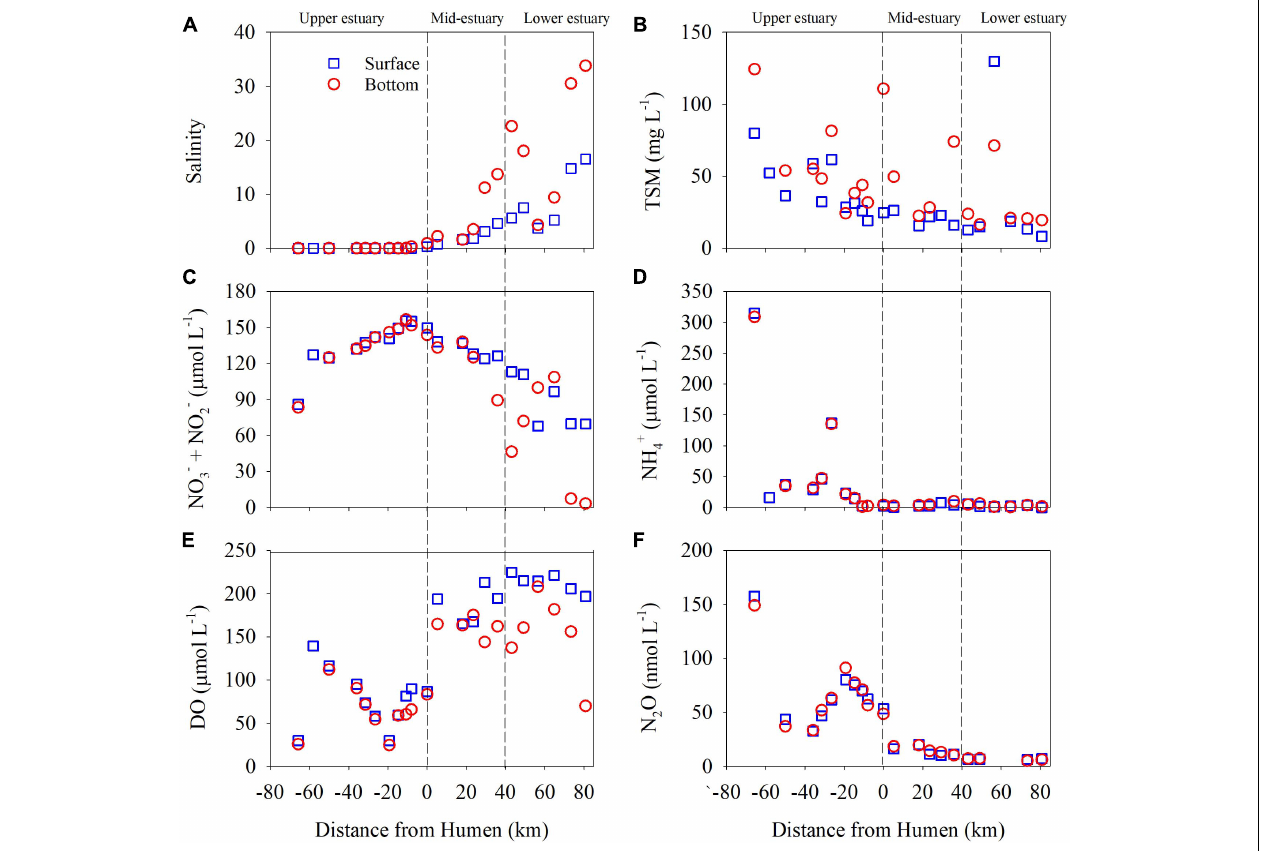
FIGURE 2 | The distributions of salinity (A) , total suspended matter (TSM) (B) , nitrate (NO 3 − ) + nitrite (NO 2 − ) (C) , ammonium (NH 4 + ) (D) , dissolved oxygen (DO) (E) , and nitrous oxide (N 2 O) (F) in the Pearl River estuary in July 2014. The dotted vertical lines separate the study sites into the upper, mid, and lower estuarine regions. The salinity and DO datasets in the mid and lower regions (Lingdingyang) were reported previously by Su et al. (2017). The blue open squares and red open dots represent samples collected in the surface and bottom waters, respectively. Humen Outlet is represented here at 0 km. Negative distance values represent sites in the upper estuary, and positive distance values represent sites in the mid- and lower estuary.